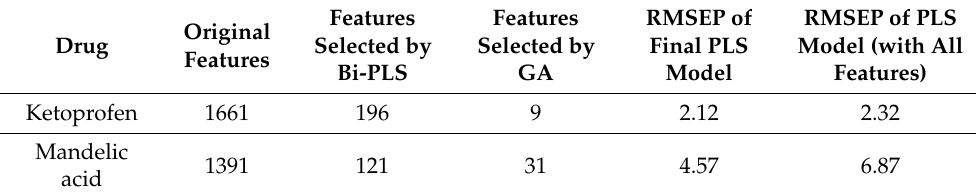
Table 5. Summary of bi-PLS-GA and final PLS model